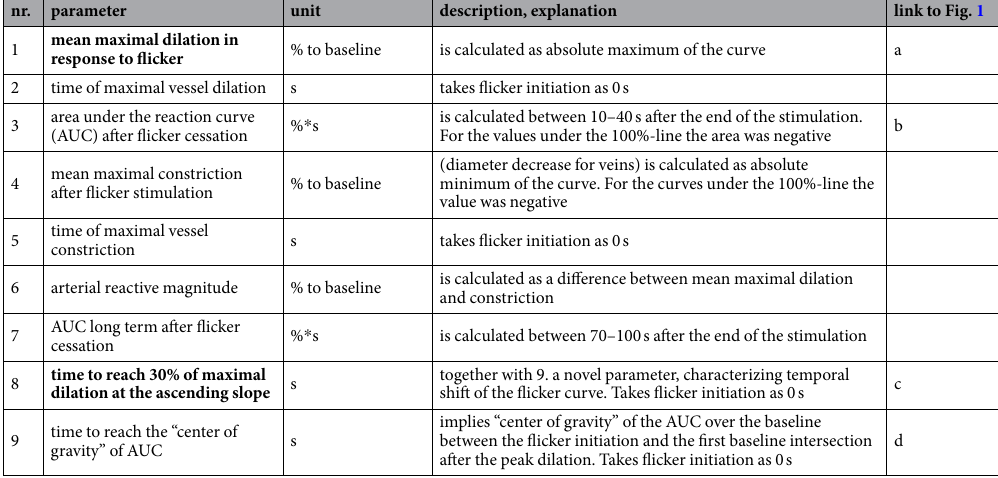
Table 1. Parameters of dynamic retinal vessel reaction to flickering light. Legend to Table 1: Parameters calculated from averaged smoothed individual time courses. Parameters of the primary analysis are accentuated bold. AUC: area under the reaction